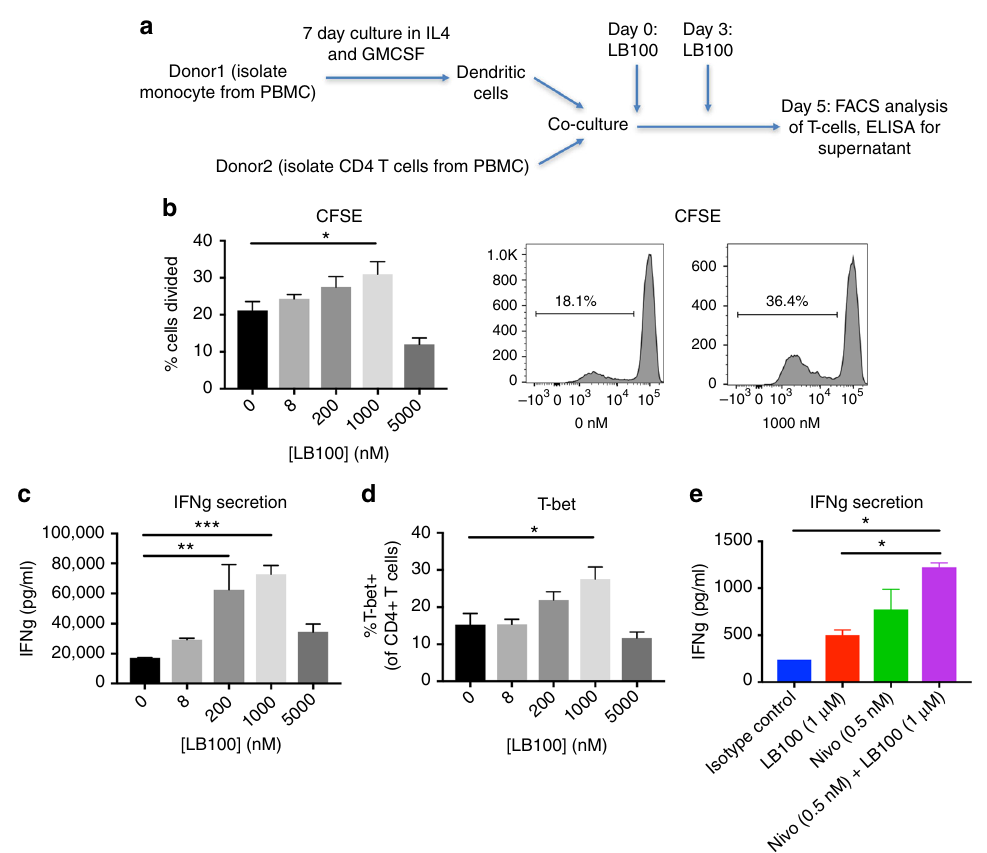
Fig. 8 PP2A inhibition enhances T-cell function in human mixed lymphocyte reactions. a DCs were induced from puri fi ed monocytes by culturing in IL4 and GM-CSF for 7 days. 10 5 puri fi ed CFSE labeled CD4 + T cells were then co-cultured with 10 4 allogenic DCs in the presence of LB-100 titration in